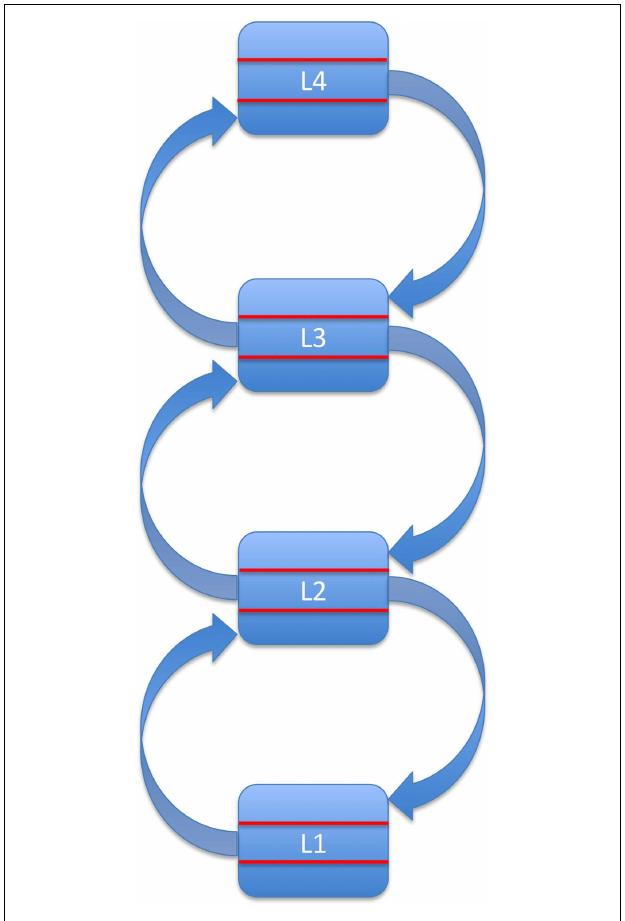
FIGURE 1 | Bottom-up processing as a series of loops formed by ascending and descending connections between neighboring levels in a hierarchically organized system. For simplicity, levels L1–L4 are shown as consisting of three layers only (ascending input, descending input, and